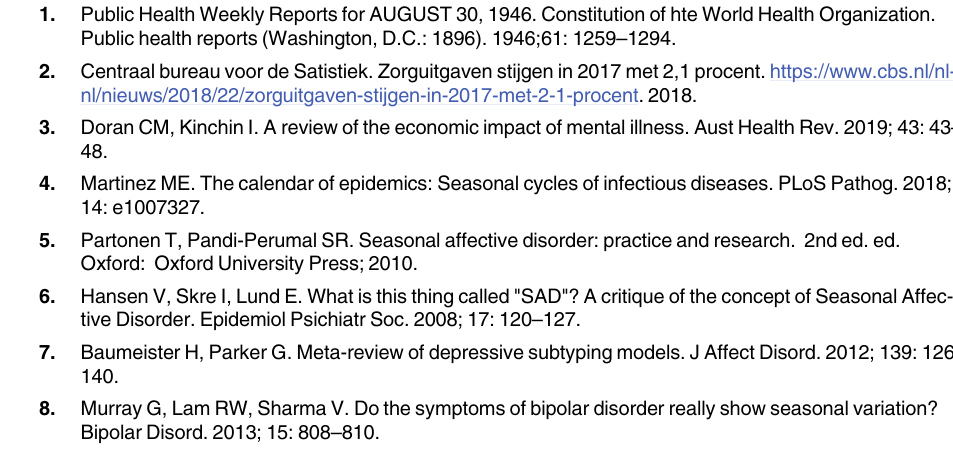
S1 Table. Correlations between PANAS, QIDS and DASS. Correlation is significant at the 0.01 level (2-tailed) ��